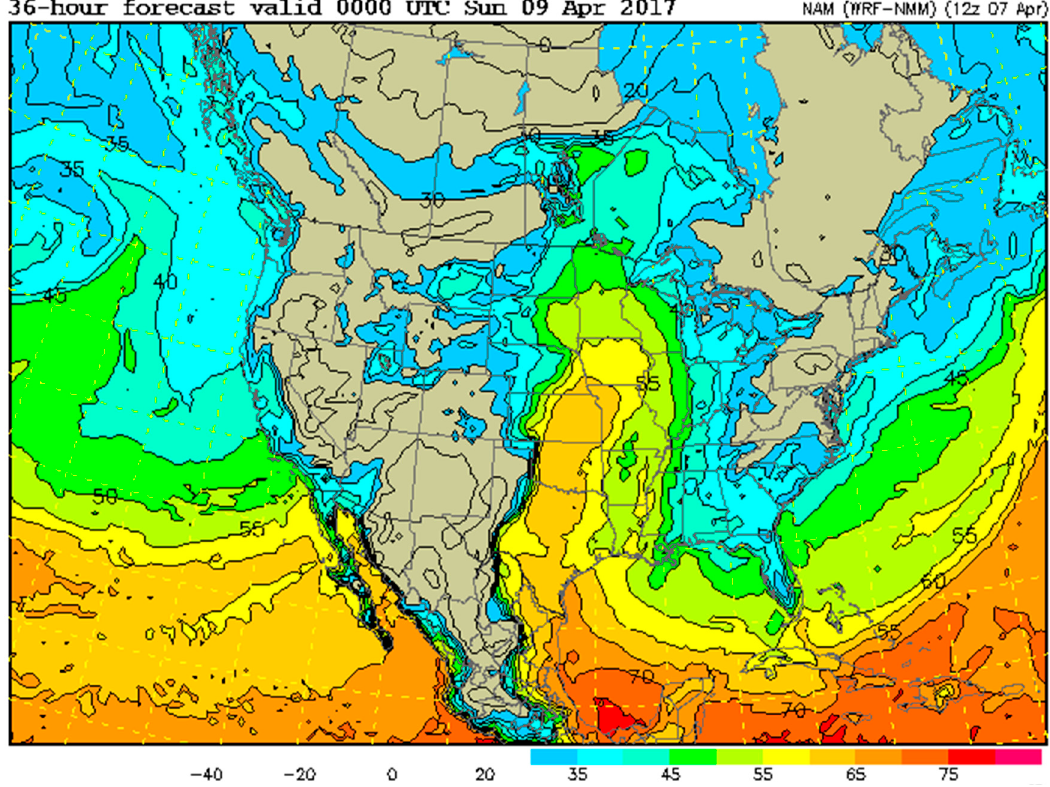
Figure 1. Operational NAM (North America Mesoscale) model forecast of 2 m dew point (°F) for 0000 UTC 9 April 2017 from 1200 UTC 7 April.